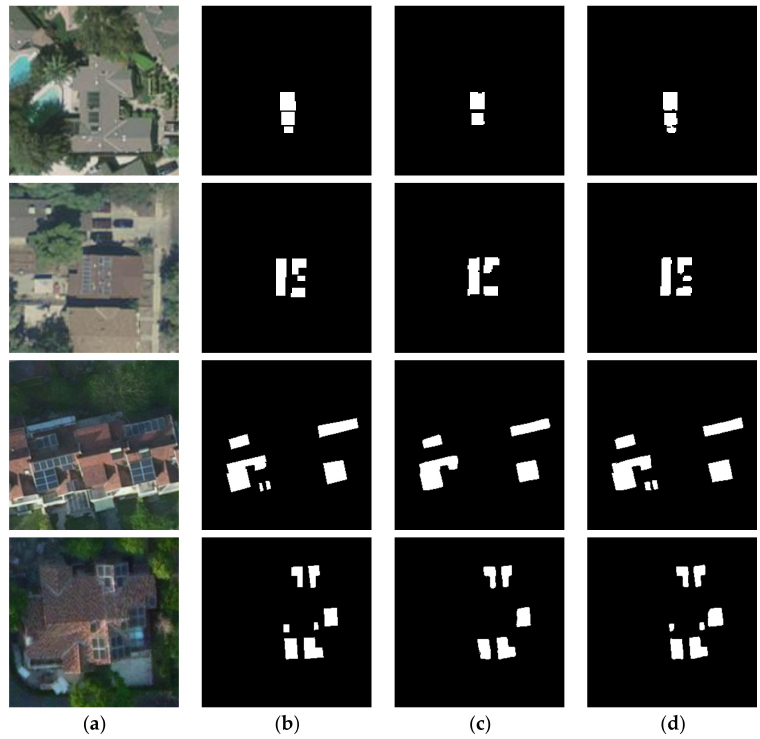
Figure 9. Result samples before and after adding GFM: ( a ) Image; ( b ) label; ( c ) E ffi -UNet results; ( d ) E ffi -UNet + GFM results.